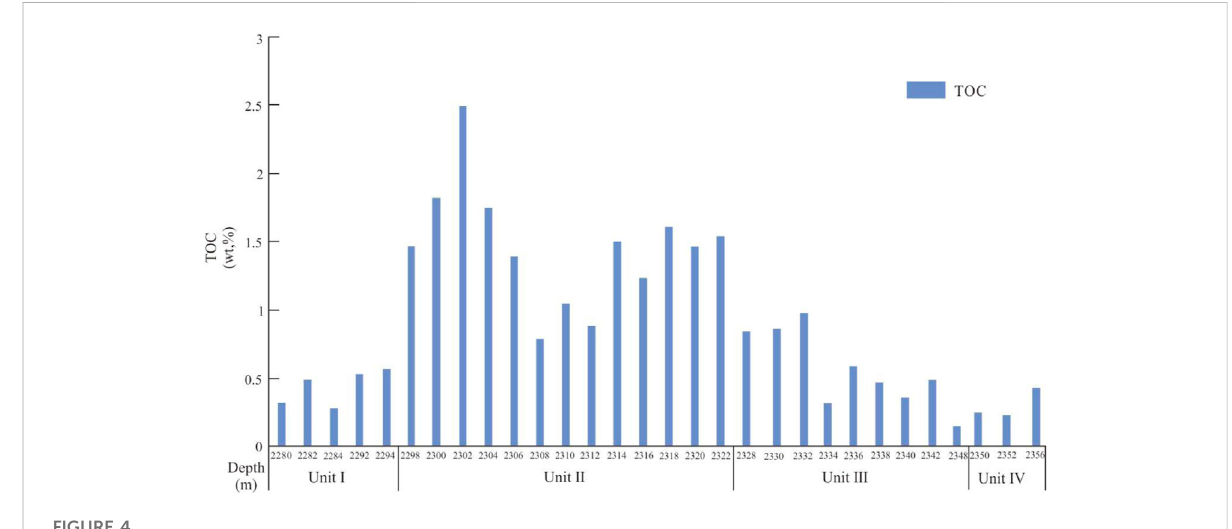
FIGURE 4 TOC distribution map in the Da ’ anzhai member of well